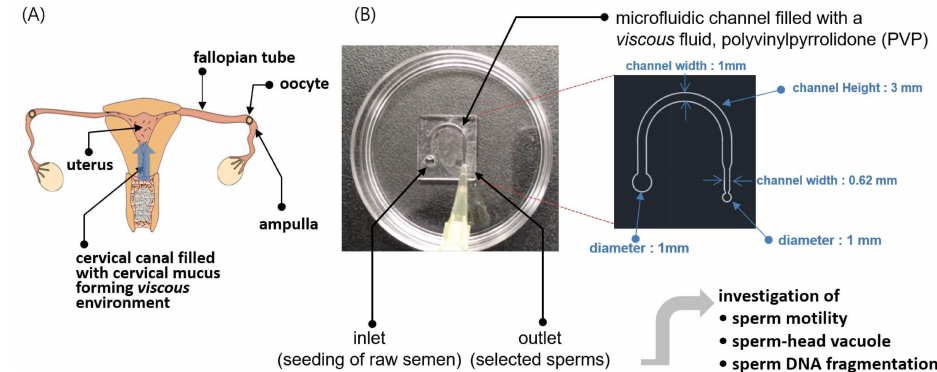
Figure 1. Schematic illustration of the methodology of the sperm-sorting chip (SSC). ( A ) Ejaculated sperm pass through the vagina and cervical canal and approach the ampulla (fertilization site) of the fallopian tube through the uterus. The cervical mucus is a fluid secreted in the cervical canal that filters out sperm with poor morphologies and low motilities as they pass into the uterus. ( B ) An SSC was developed to select high-quality sperm in vitro using the microfluidic technique, in which a viscous polyvinylpyrrolidone (PVP)-based solution was used as the medium to imitate the viscous environment of cervical mucus in vivo. The viscosity of the PVP medium was tuned to that of the cervical mucus via micro-viscometry. The sperm selected by the SSC were experimentally analyzed for motility, head vacuole, and DNA fragmentation as well as theoretically assessed via numerical